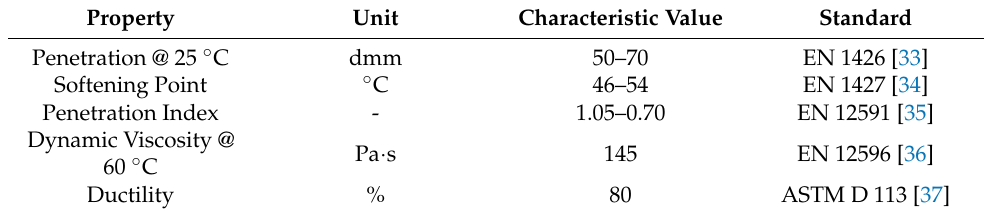
Table 3. Conventional properties of the adopted